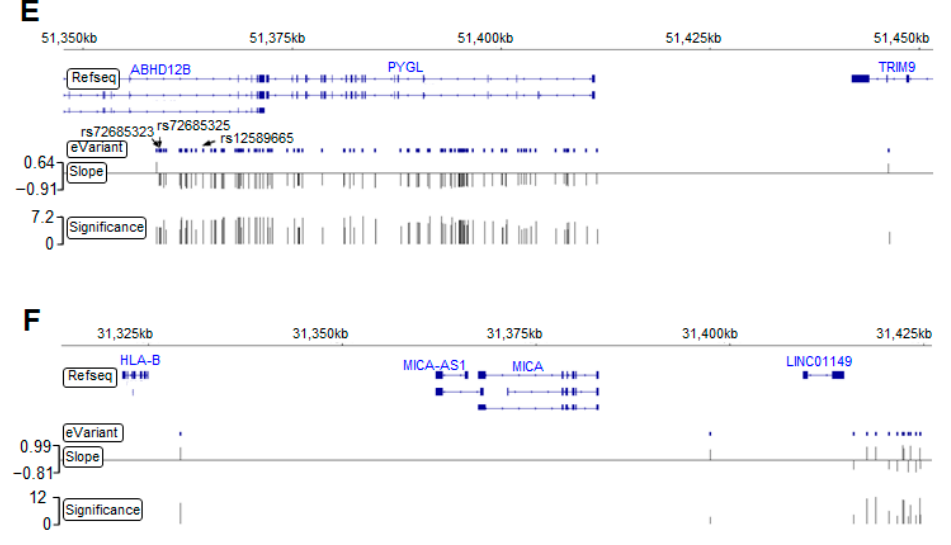
Figure 2. Germline eVariants that regulate immune response eGene expression by eQTL mapping analyses. ( A ) Manhattan plot of all cis-eQTL. The red line indicates significance (with a p -value of 1 × 10 − 3 ). Red, orange, and purple circles indicate the eQTL related to HLA-B , PYGL , and FCER1G , respectively. ( B ) Histogram showing the distribution of eQTL distances in megabases (Mb) from the transcription start site (TSS). Scatter plot showing the distribution of eQTL significance and distance from the TSS. ( C ) Histogram showing tissues sharing the same eQTL in the GTEx. With the significance increasing, overlapping eQTL were most frequently found in the esophageal mucosa and transverse colon. ( D ) Histogram showing overlapping eGenes in the GTEx. PYGL was the most frequently observed eGene in the GTEx, with a high significance. ( E ) Case study for PYGL . The eVariants track shows the eVariants that regulate the expression of PYGL (chr14:51371934– 51411428) through our pipeline. The sloping track indicates the slope derived from eQTL mapping. A positive slope indicates that gene expression was upregulated through the gain of alternative alleles. The significance track indicates the negative log-transformed p -values derived from eQTL mapping. Predictive eVariants reported by Bien et al. (rs72685323, rs72685325, and rs12589665) were associated with the downregulation of PYGL , with slopes of − 0.697 ( p = 4 × 10 − 5 ), − 0.675 ( p = 4.36 × 10 − 5 ), and − 0.847 ( p = 6.05 × 10 − 7 ), respectively. ( F ) Case study for HLA-B . The eVariants track shows